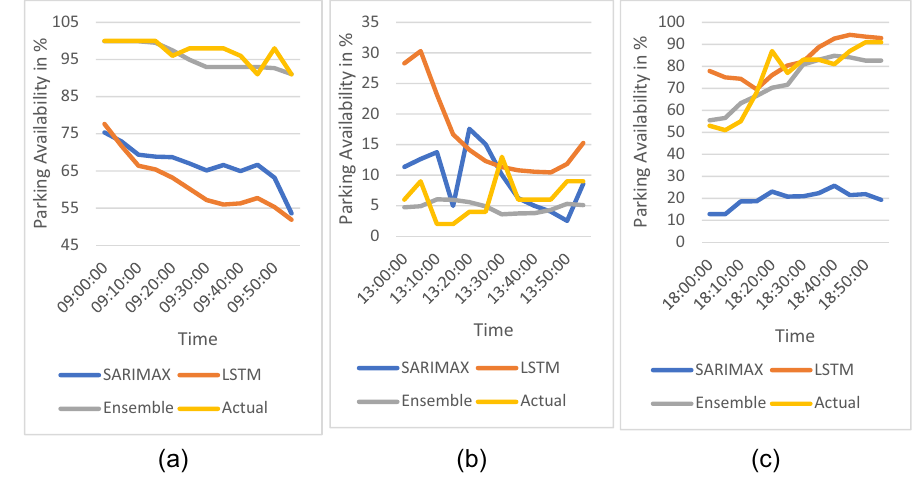
Figure 6: Prediction plot of methods without visitor trend data for the weekend. ( a ) Predictions without visitor trend data at 9 AM on weekend. ( b ) Predictions without visitor trend data at 1 PM on weekend. ( c ) Predictions without visitor trend data at 6 PM on weekend.